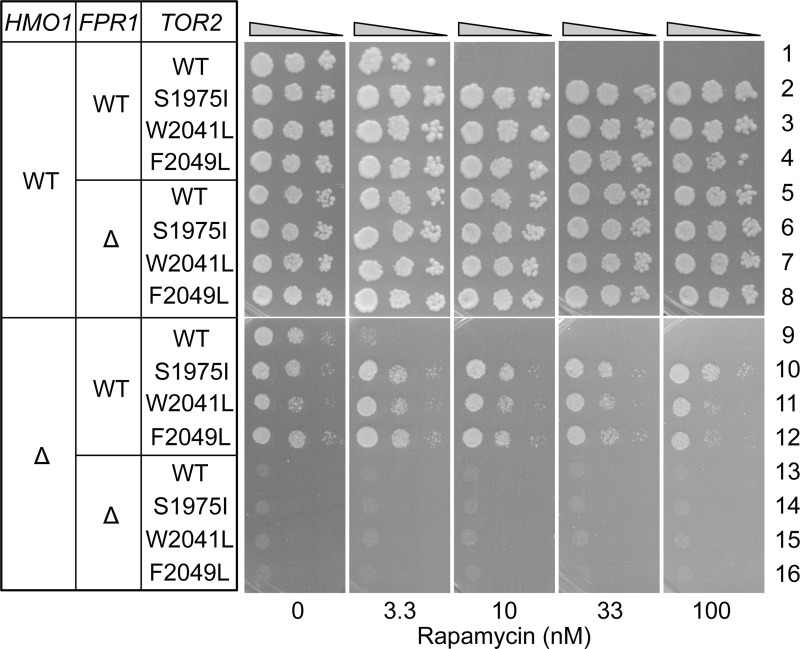
Effect of tor2 mutations on the function of Fpr1 on RPG promoters.Effect of tor2 mutations on the growth of WT, fpr1Δ, hmo1Δ, and hmo1Δfpr1Δ cells was examined using spot assays. Plasmids containing tor2-S1975I (pKM802), tor2-W2041L (pKM804), and tor2-F2049L (pKM806) mutant genes or WT TOR2 (pKM782) were introduced into tor1Δtor2Δ [YKK1081], tor1Δtor2Δfpr1Δ [YKK1080], tor1Δtor2Δhmo1Δ [YKK1093], or tor1Δtor2Δhmo1Δfpr1Δ [YKK1097] cells. Subsequently, a plasmid containing WT TOR2 and URA3 (pKM731), which was pre-introduced into the host cells, was depleted through plasmid shuffling (using SD plates containing 5-fluoroorotic acid). The resulting strains were spotted onto SD plates containing or not containing rapamycin as indicated, and grown at 30°C for 3 days.